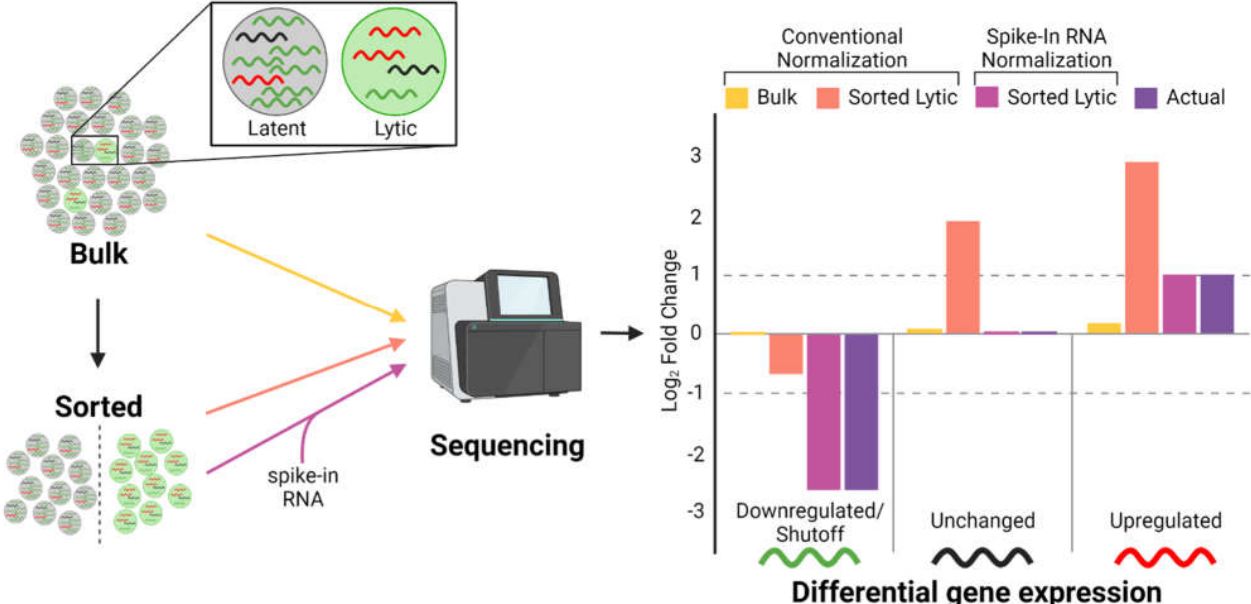
Figure 2. Barriers and potential solutions for accurate quantification of host shutoff. The inefficient and asynchronous entry of EBV into lytic replication means that bulk populations of EBV infected cells are predominantly latently infected with decreasing levels of early and late lytic infection. As a consequence, detection of differentially expressed genes is diminished, especially mRNAs that are downregulated (or degraded) in lytic cells, such as those subject to host shutoff (compare bulk to actual). This limitation can be addressed via cell sorting approaches; however, given the marked differences in total mRNA in latent versus lytic cells, conventional normalization methods fail to accurately measure changes in gene expression. To account for such differences, exogenous spike-in RNAs can be added on a per cell basis. These (or similar) modifications are essential to capture host shutoff effects accurately on the cell gene expression. Figure created with